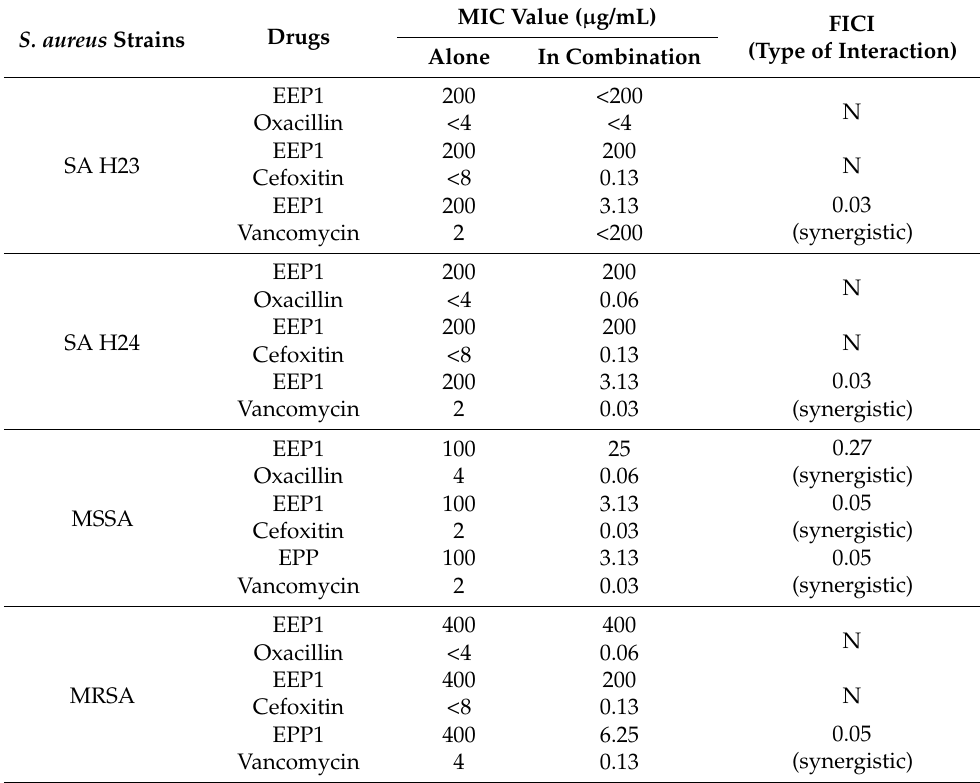
Table 2. The MIC value of EEP1 alone and in combination with antibiotics on S. aureus (inoculum of 10 8 CFU/mL); clinical isolates (SA H23 and SA H24), reference strains methicillin-susceptible S. aureus ATCC 29213 (MSSA), and methicillin-resistant S. aureus ATCC 700699 (MRSA), and the type of interaction according to fractional inhibitory concentration index (FICI), (N) not calculated. MIC Value ( µ g/mL) FICI S. aureus Strains Drugs (Type of Interaction)Alone In